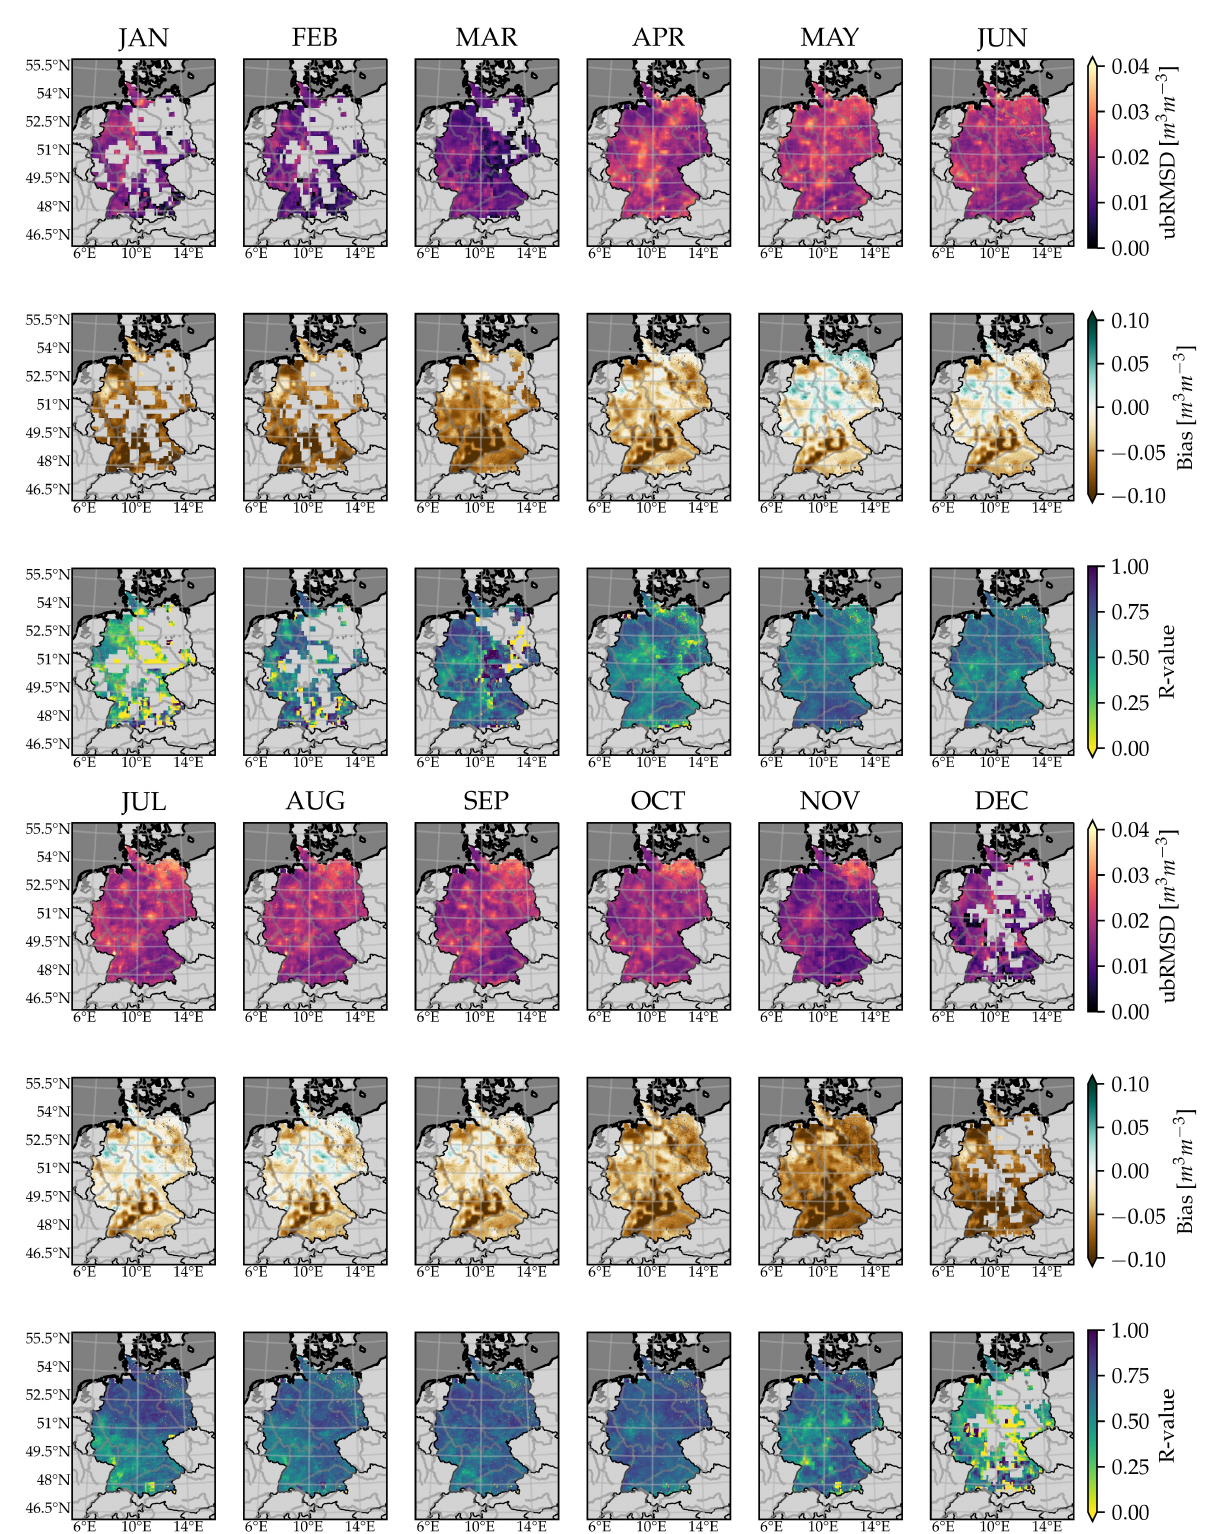
Figure A1. Monthly ubRMSD , bias , and R between API and ESA CCI SM